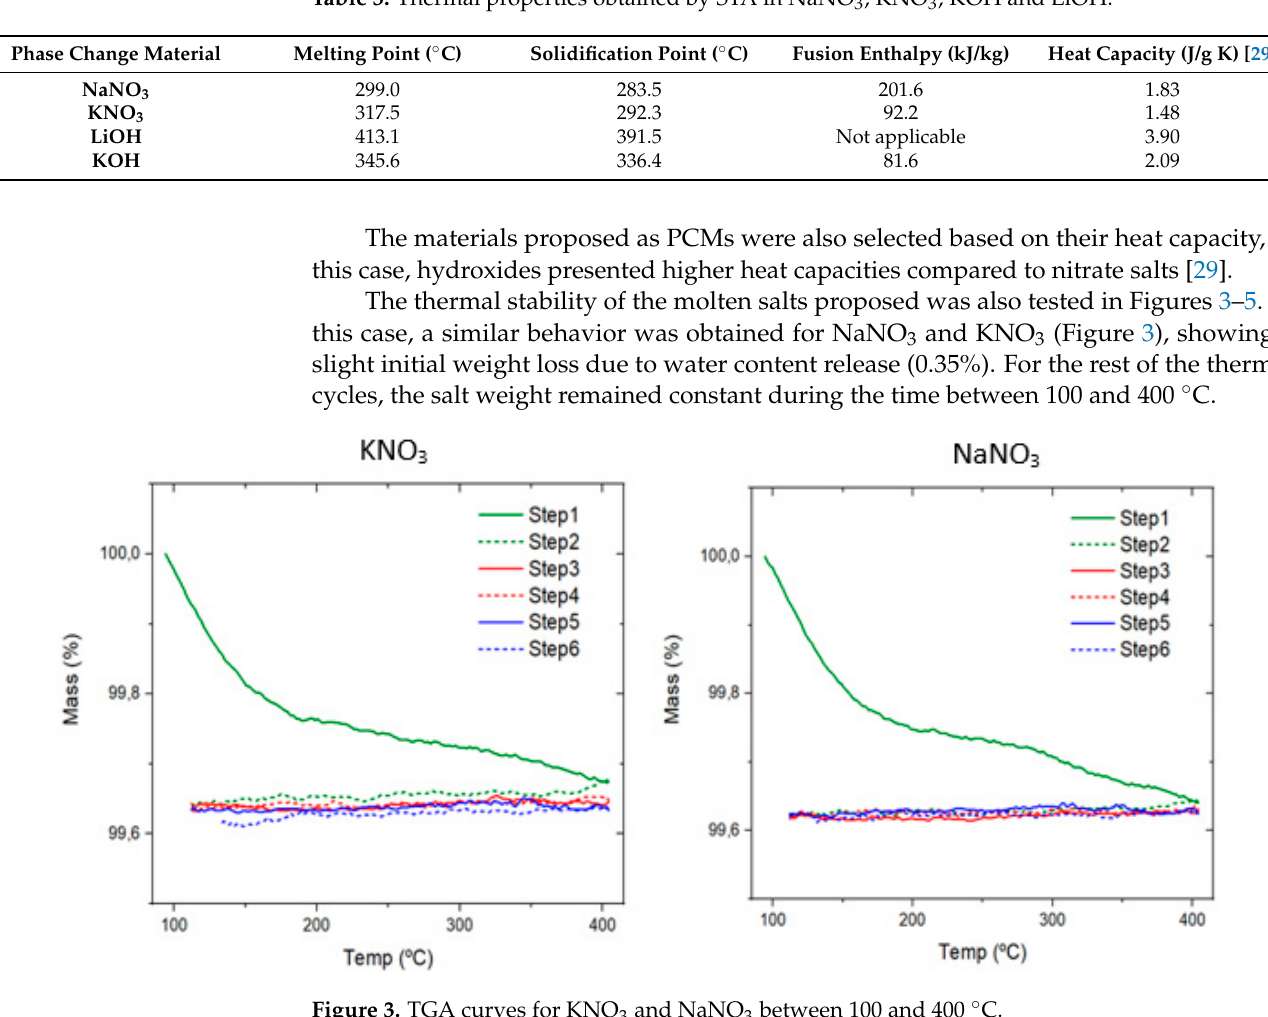
Figure 3. TGA curves for KNO 3 and NaNO 3 between 100 and 400 °C.